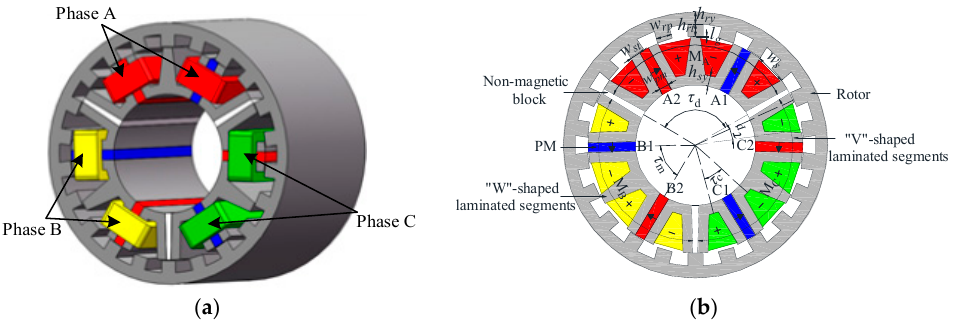
Figure 1. Structure of the MSOR-FSPM motor: ( a ) 3D structure of the MSOR-FSPM motor; ( b ) Cross-sectional view of the MSOR-FSPM motor. ( b ) Cross-sectional view of the MSOR-FSPM